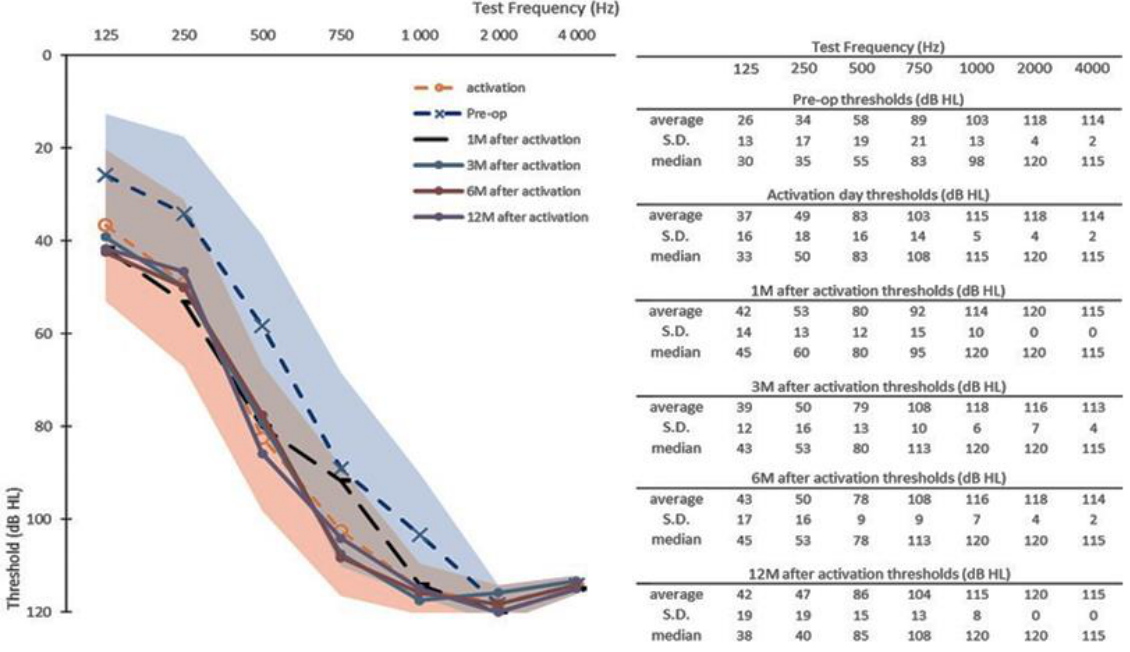
Figure 3. Pre-operative hearing thresholds (Pre-op, n = 6), post-operative hearing thresholds at activation day ( n = 6), at one month (1M) after activation ( n = 6), at three months (3M) after activation ( n = 6), at six months (6M) after activation ( n = 6) and at 12 months (12M) after activation ( n = 6). Shaded areas represent the maximal and minimal standard deviations of the pre-operative data (in blue) and of the activation day data (in orange). S.D. = standard deviation .